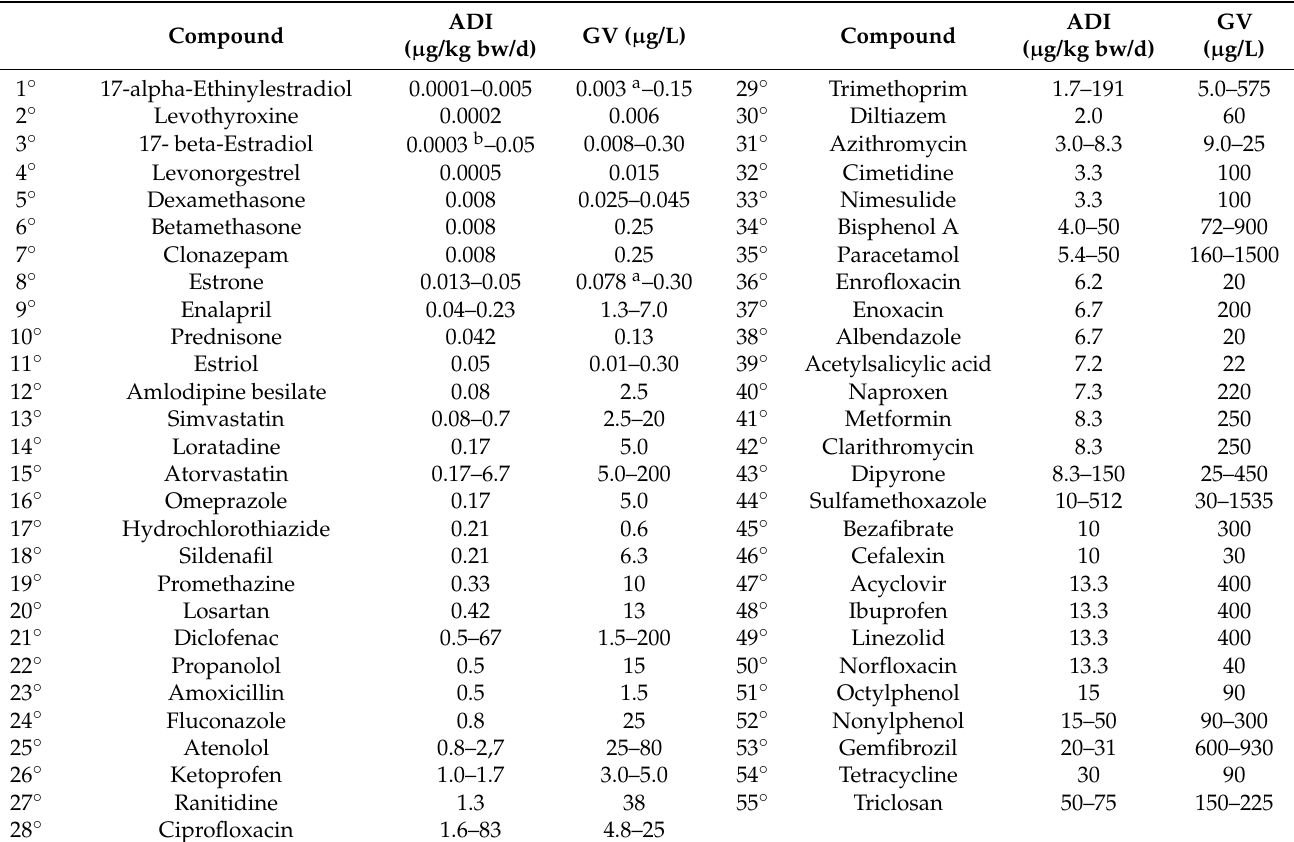
Table 3. Toxicity ranking of pharmaceuticals and endocrine disrupting compounds (P&EDC) based on the lowest calculated values of acceptable daily intake (ADI) in comparison to the guideline value